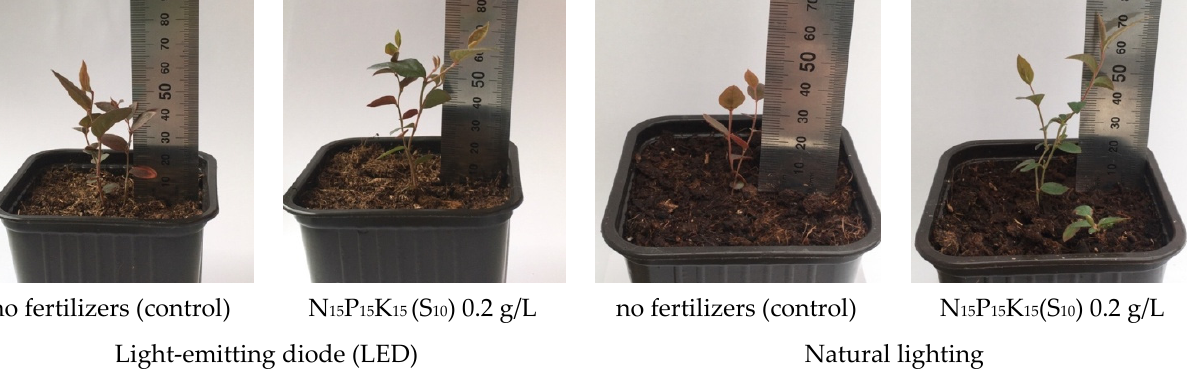
Figure 2. External appearance of ex vitro highbush blueberry ( Vaccinium corymbosum L.) plants on the 14th day of growing completion.